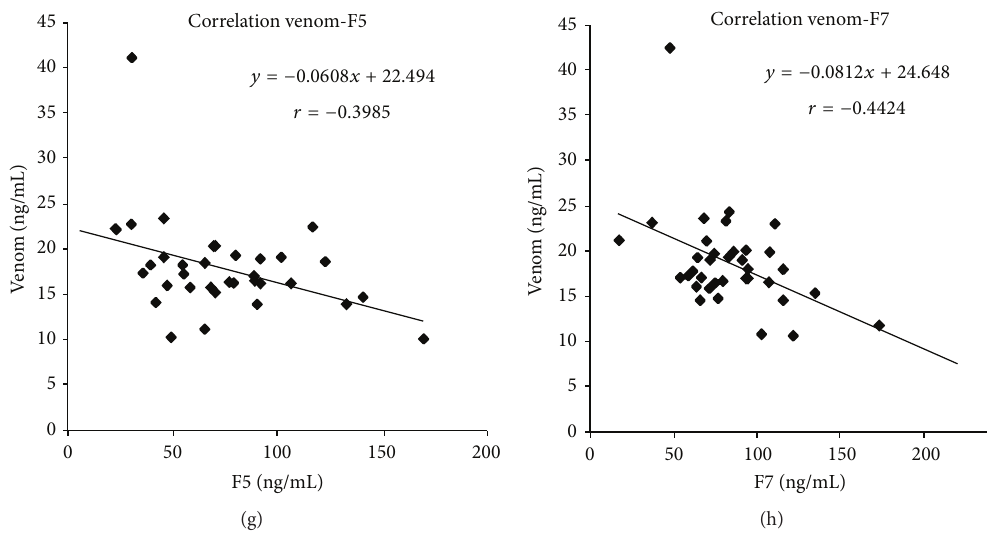
Figure 6: F2, F5, F7, D dimers, and venom: correlations in BP